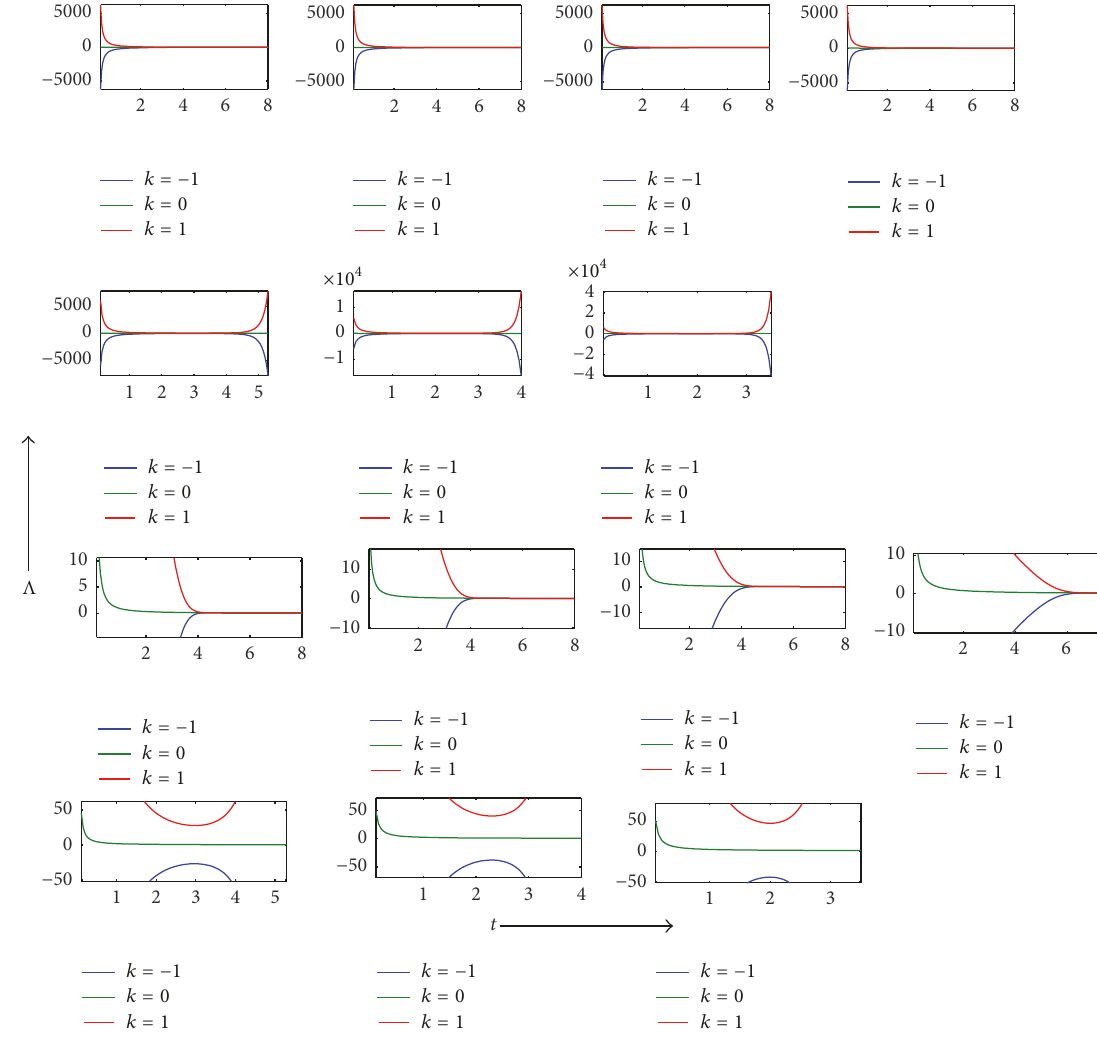
Figure 8: Variation of cosmological constant Λ against time for 𝛼 1 = 0.5 , 𝛼 2 = 0.5 , 𝜔 = 1 , 𝑐 2 = 0.1 , and different 𝛼 (0.2,0.4, 0.6, 0.8, 0.9, 1.1, 1.3) . Lower two rows represent the magnified portion of the above two rows. 4